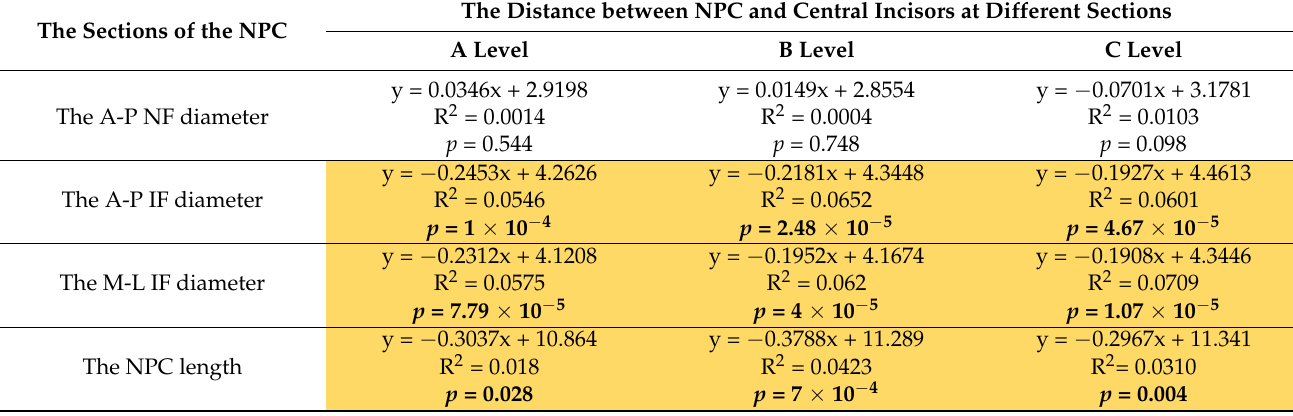
Table 2. Relationship between NPC diameter at different sections and distance to central incisors. The Sections of the NPC